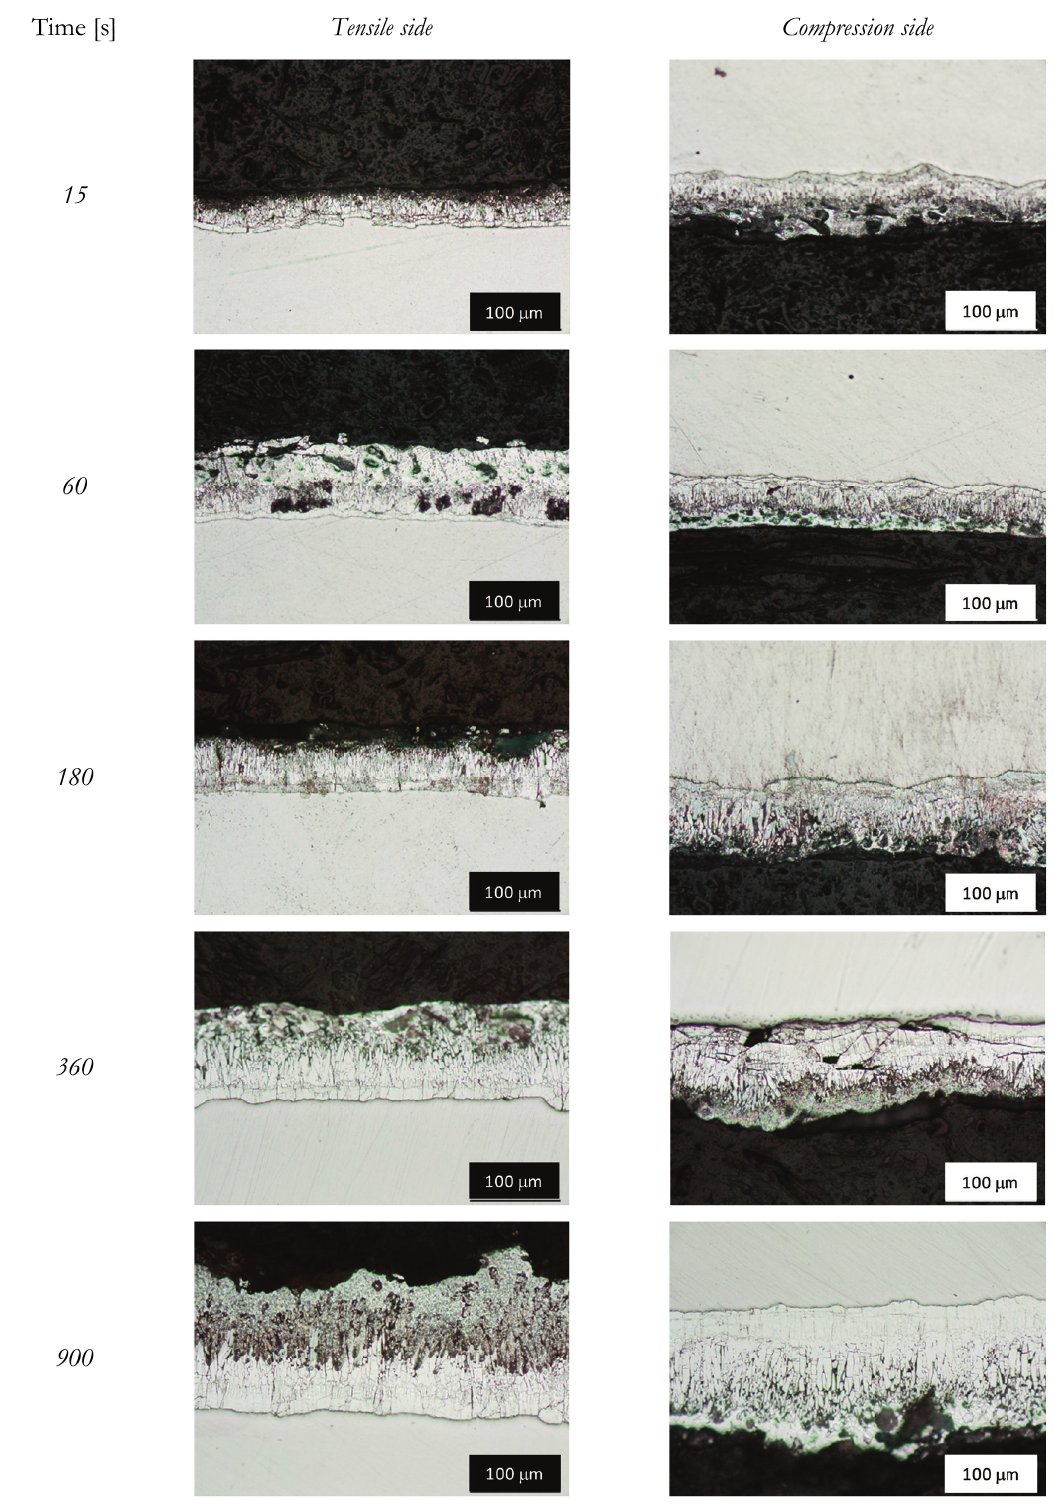
Figure 11: Coatings o